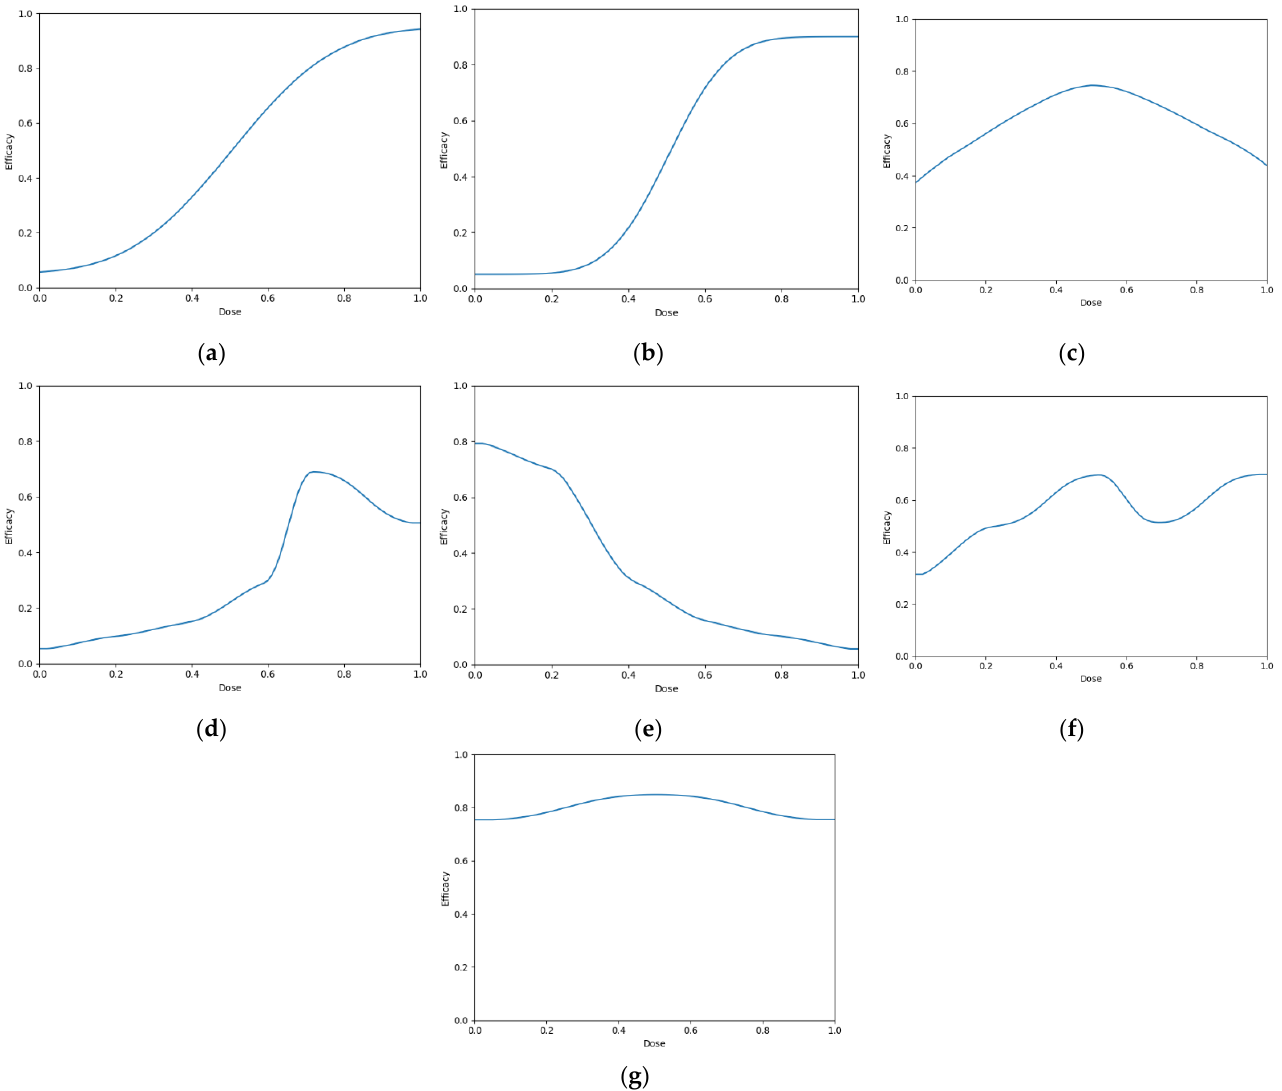
Figure 6. Dose-efficacy plots for the seven objective 1 scenarios. These were ( a ) scenario 1, ( b ) sce- nario 2, ( c ) scenario 3, ( d ) scenario 4, ( e ) scenario 5, ( f ) scenario 6, and ( g ) scenario 7. Purple represents areas of higher efficacy. The blue line represents the probability of efficacious response for each